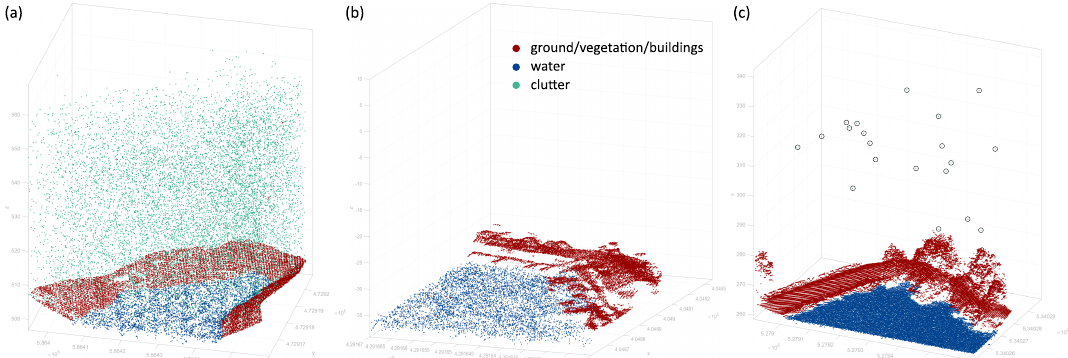
Figure 6. Perspective views of 3D point clouds; ( a ) Single Photon LiDAR (Navarra), ( b ) Single Photon LiDAR (Easton), ( c ) Multi-Photon LiDAR (Neubacher Au); size of displayed areas: 75m ×